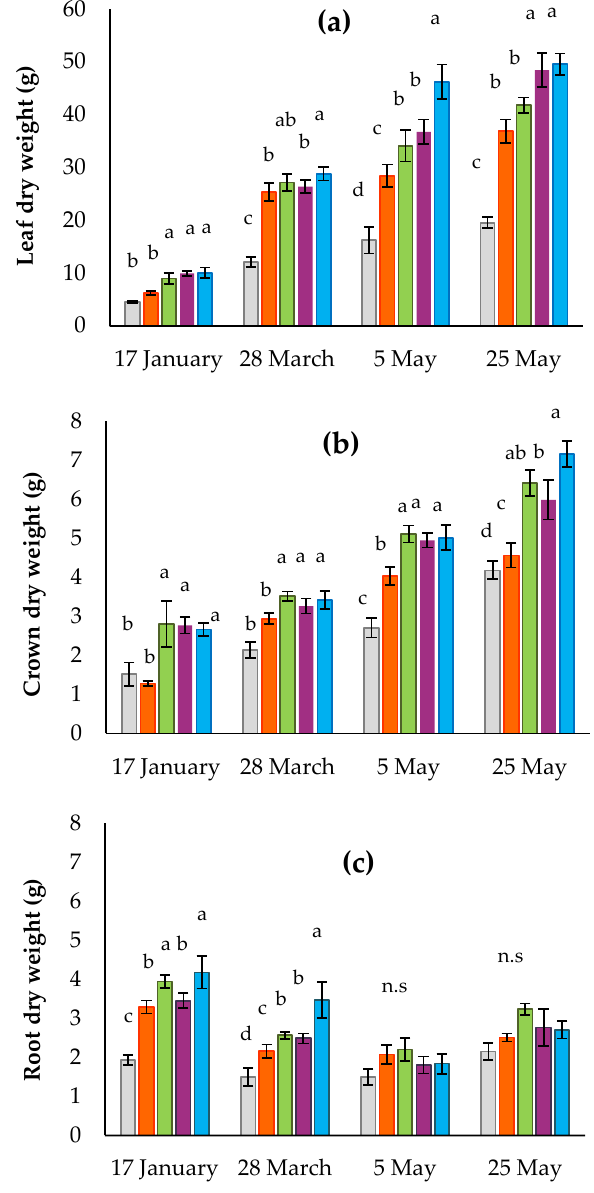
Figure 4. Effect of the different soil pre-plant treatments on the leaf ( a ) (top), crown ( b ) (middle), and root ( c ) (below) dry weight of Sabrosa* plants during the 2019/20 cropping season (second year trial). Bars are average ± standard error. Within the same sampling date, bars marked by different letters are significantly different ( p ≤ 0.05, Tukey HSD test); n.s. = non significant ( p ≤ 0.05).